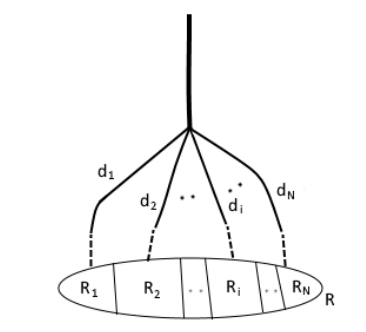
Figure 2. Resistance distribution from parent branch to child